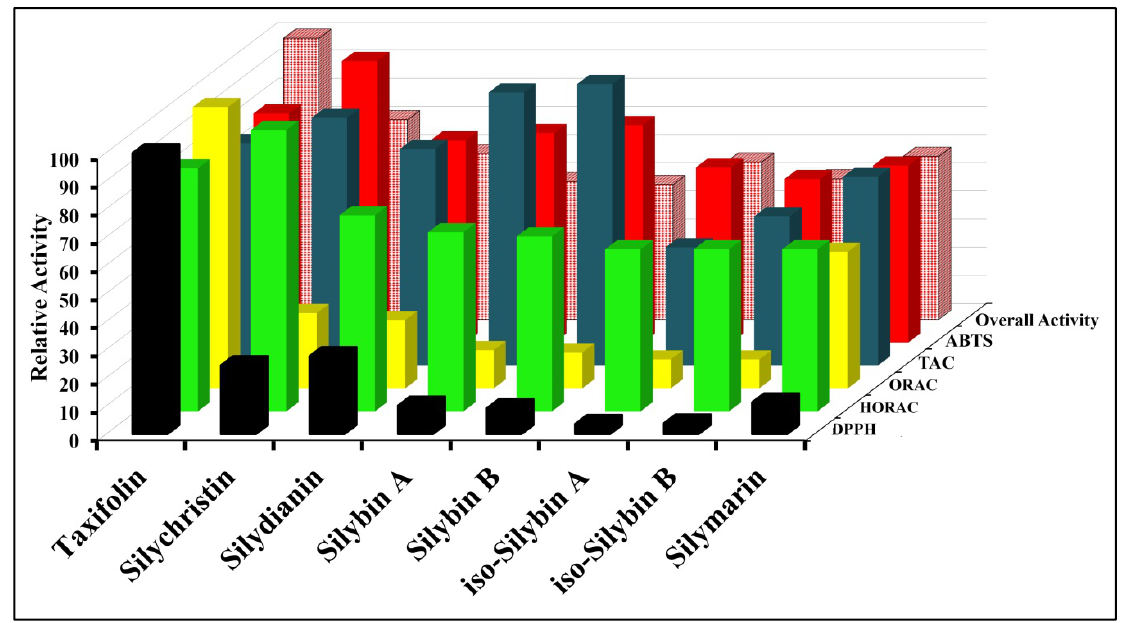
Figure 3. Overall antioxidant activity of silymarin and its individual